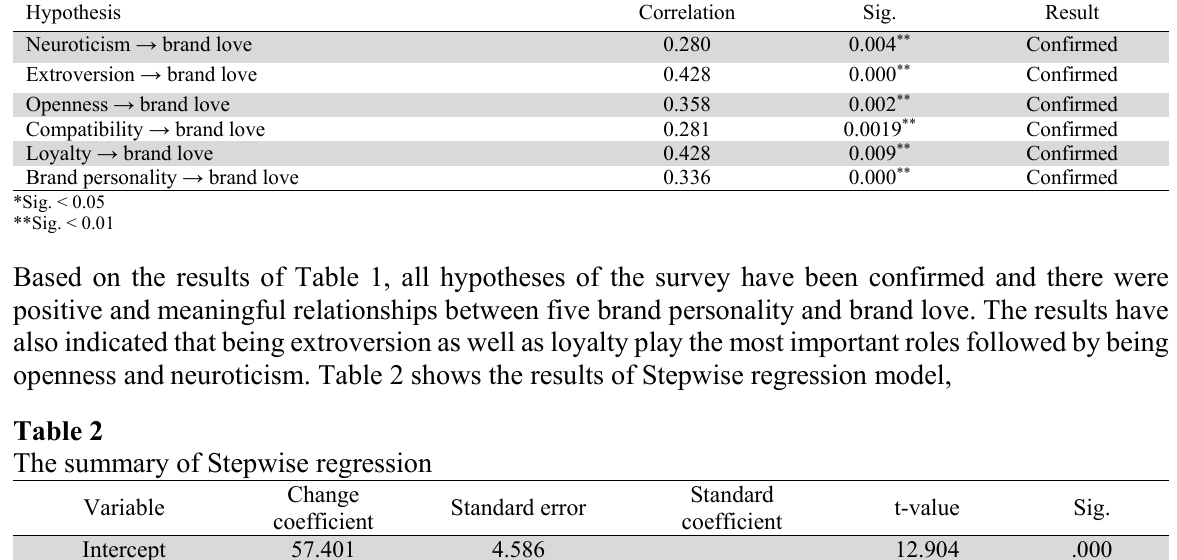
The summary of Spearman correlation test